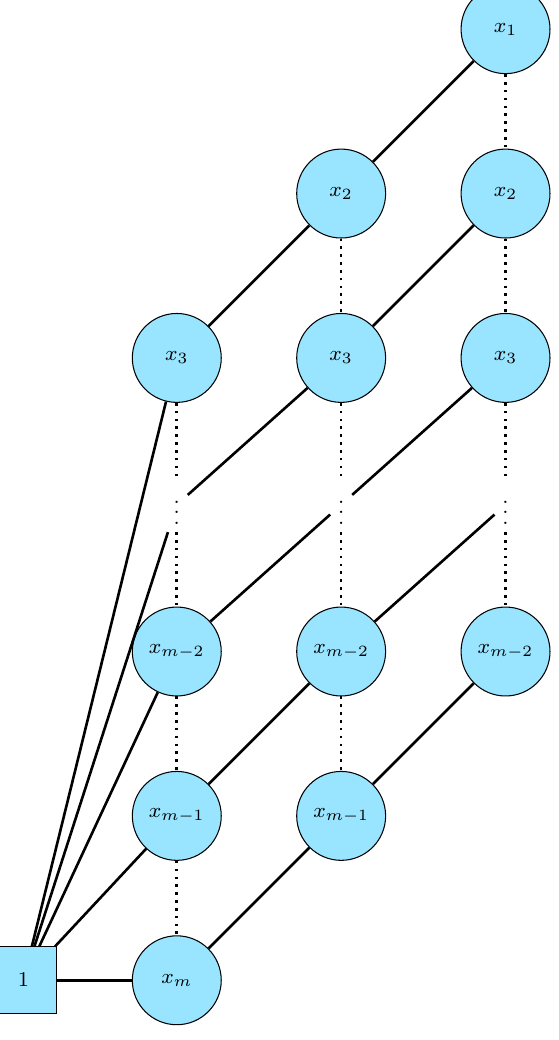
Figure 8. A BDD representing atLeast-3 for m >